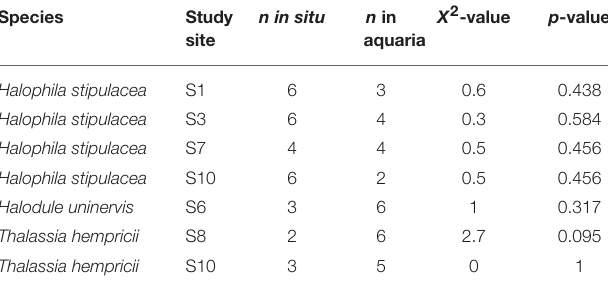
n indicates the number of